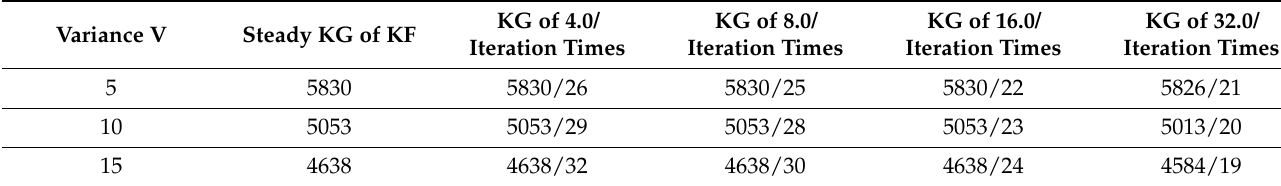
Table 2. Best Standard Value of Conditional